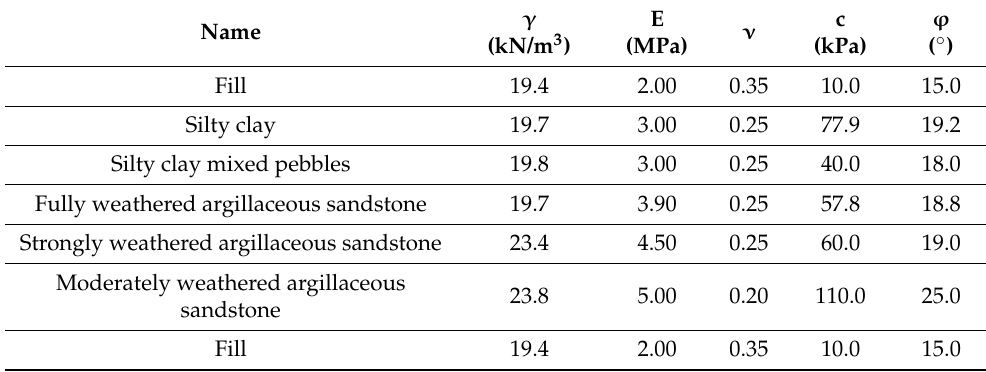
Table 2. Soil physical and mechanical parameters of finite element model.